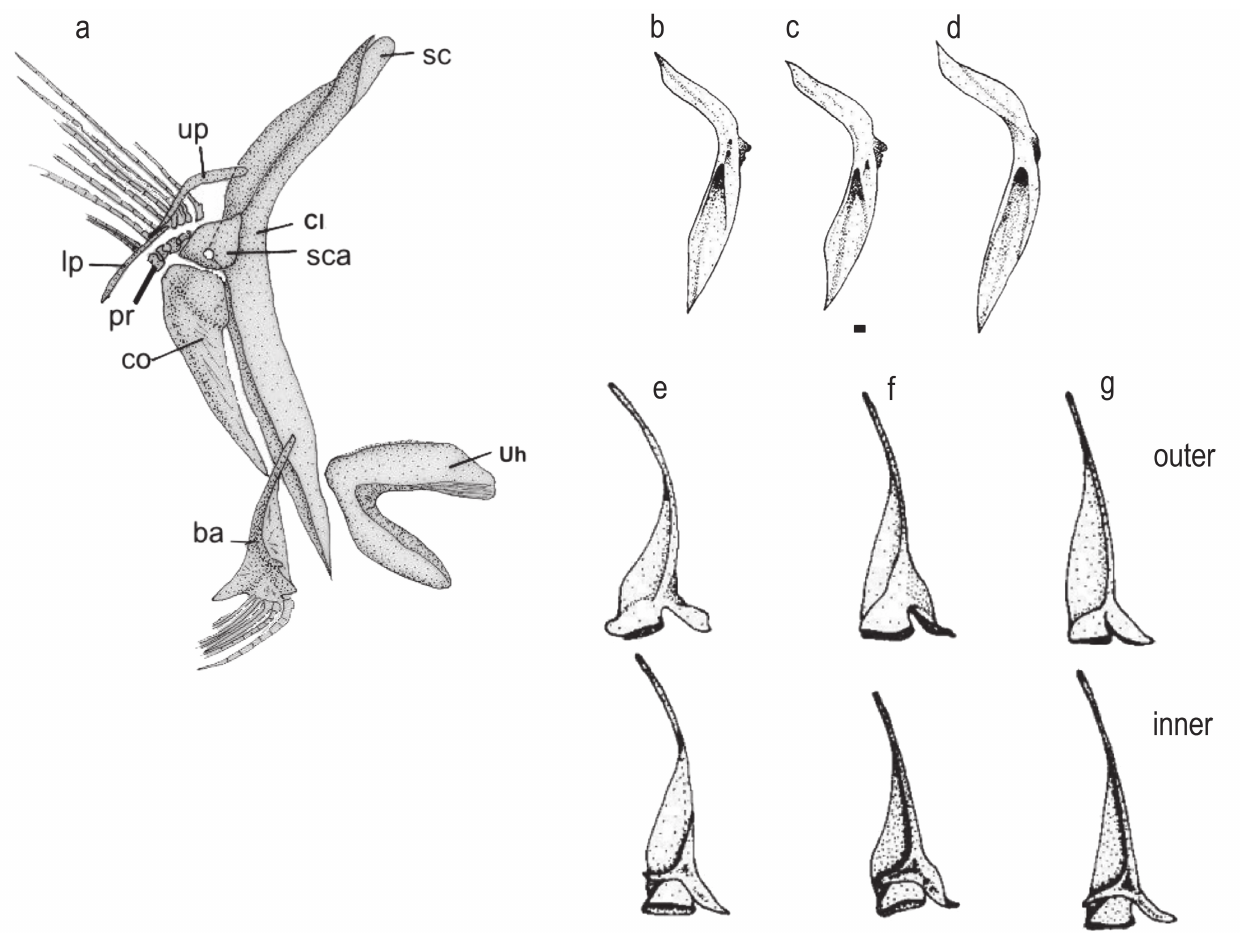
Fig. 6. Inner view of left pectoral girdle of Paralichthys patagonicus ( a ). Left cleithra of Paralichthys patagonicus ( b ), P. orbignyanus ( c ), and P. isosceles ( d ). Left and right basipterygia in outer and inner views of Paralichthys patagonicus ( e ), P. orbignyanus ( f ), and P. isosceles ( g ). See abbreviations in text. Scale bar indicates 1